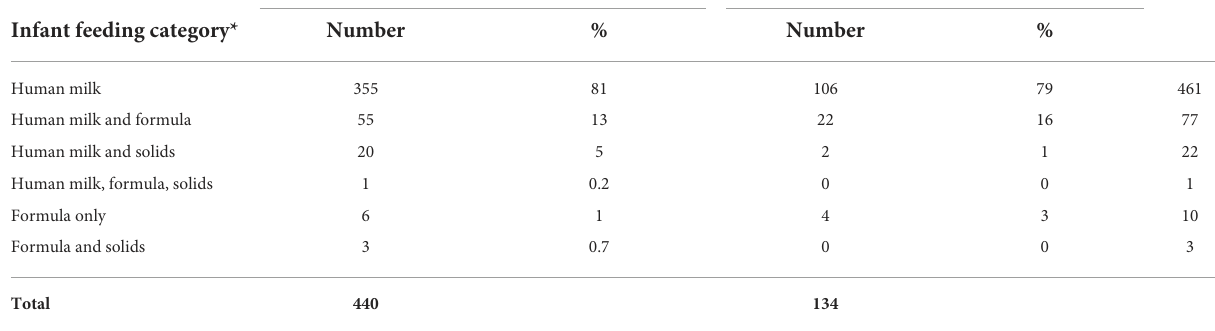
TABLE 4 Comparison of infant feeding at the time of survey among 574 respondents with infants < 6 months of age, stratified by a delivery date before or after March 13,